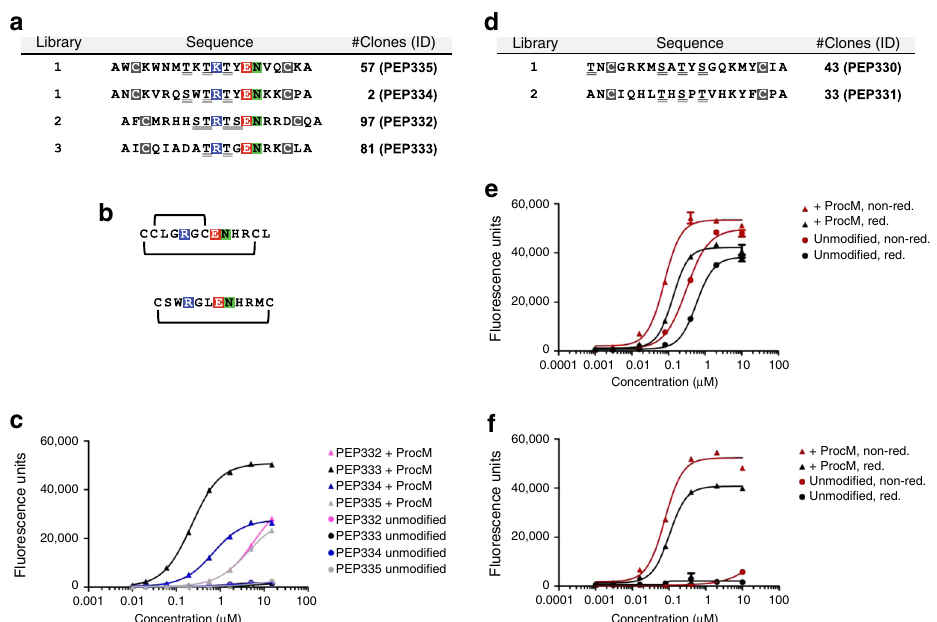
Fig. 4 Phage selection outcome and characterization of identi fi ed lanthipeptides. a Amino-acid sequences of speci fi c clones selected on uPA. The library in which the clones were found, the number of clones with identical sequences, and a unique clone ID are indicated. Fixed cysteine positions are boxed (gray), putative sites of dehydration (serines and threonines) are underlined, and a conserved three residue motif is highlighted (colored). b Sequence and disul fi de pattern of bicyclic and monocyclic uPA-speci fi c peptides described in the literature. c ELISA for uPA binding of puri fi ed His 6 -tagged leader-core peptides produced with (+ProcM) or without (unmodi fi ed) ProcM co-expression. Data representing mean ± s.d. of three replicates is shown (curve fi t with nonlinear regression). d As in a , but amino-acid sequences of speci fi c clones selected on streptavidin are shown. e ELISA for streptavidin binding of puri fi ed His 6 -tagged leader-core peptide PEP330 produced with or without ProcM co-expression and analyzed under reducing (red) and non-reducing (non-red.) conditions. f As in e , but binding curves of PEP331 are shown. Experiments shown in c , e , and f were repeated three